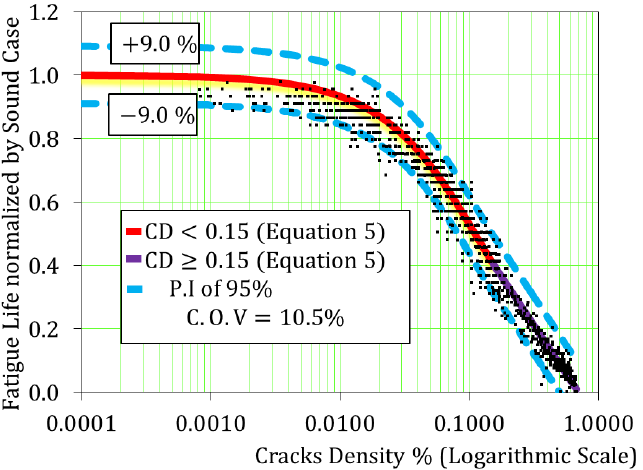
Figure 11. Proposed correlation for the remaining fatigue life prediction by using cracks density parameter.